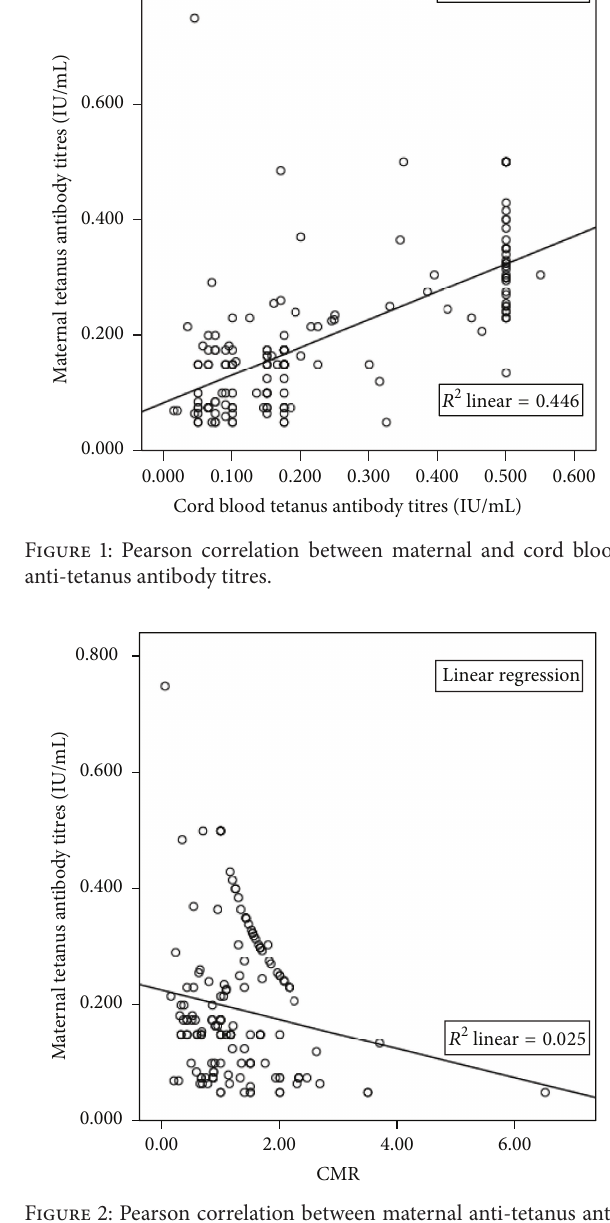
Table 1: Sociodemographic and obstetric characteristics of the mothers studied.